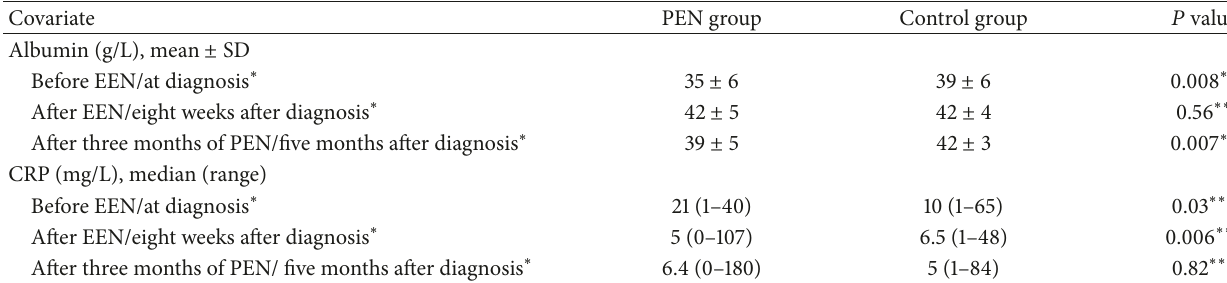
Table 3: Laboratory parameters.